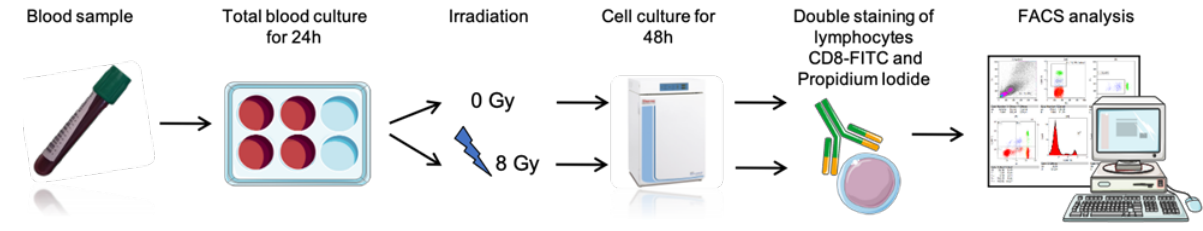
Figure 1. RILA assay procedure (adapted from Brengues et al. [36]). Blood samples were collected from donors in Heparin tubes, diluted in RPMI medium (1:10) and then cultured in 6-wells plate at 37 ◦ C, 5% CO 2 for 24 h prior to ex-vivo irradiation (0 or 8 Gy). Irradiated whole blood was cultured for 48 h, red blood cells were lysed and the remaining cells were labeled with FITC-conjugated anti-CD8 monoclonal antibodies to select CD8 + T-lymphocytes that were then stained with propidium iodide (PI). Cells were analyzed by flow cytometry to determine the percentage of apoptotic